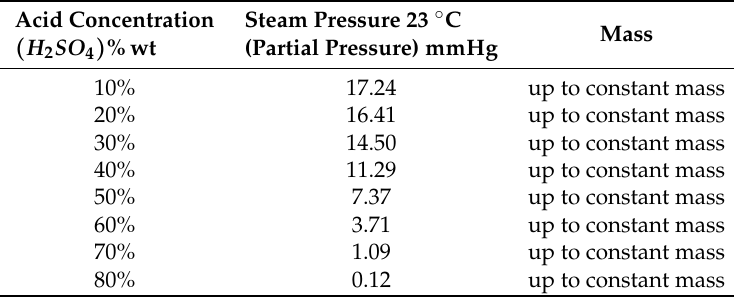
Table A3. Measurement of different concentrations ( H 2 SO 4